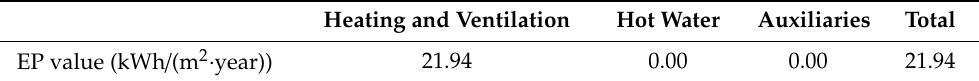
Table 16. The annual primary energy demand (kWh / (m 2 · year)) for the multi-family building at